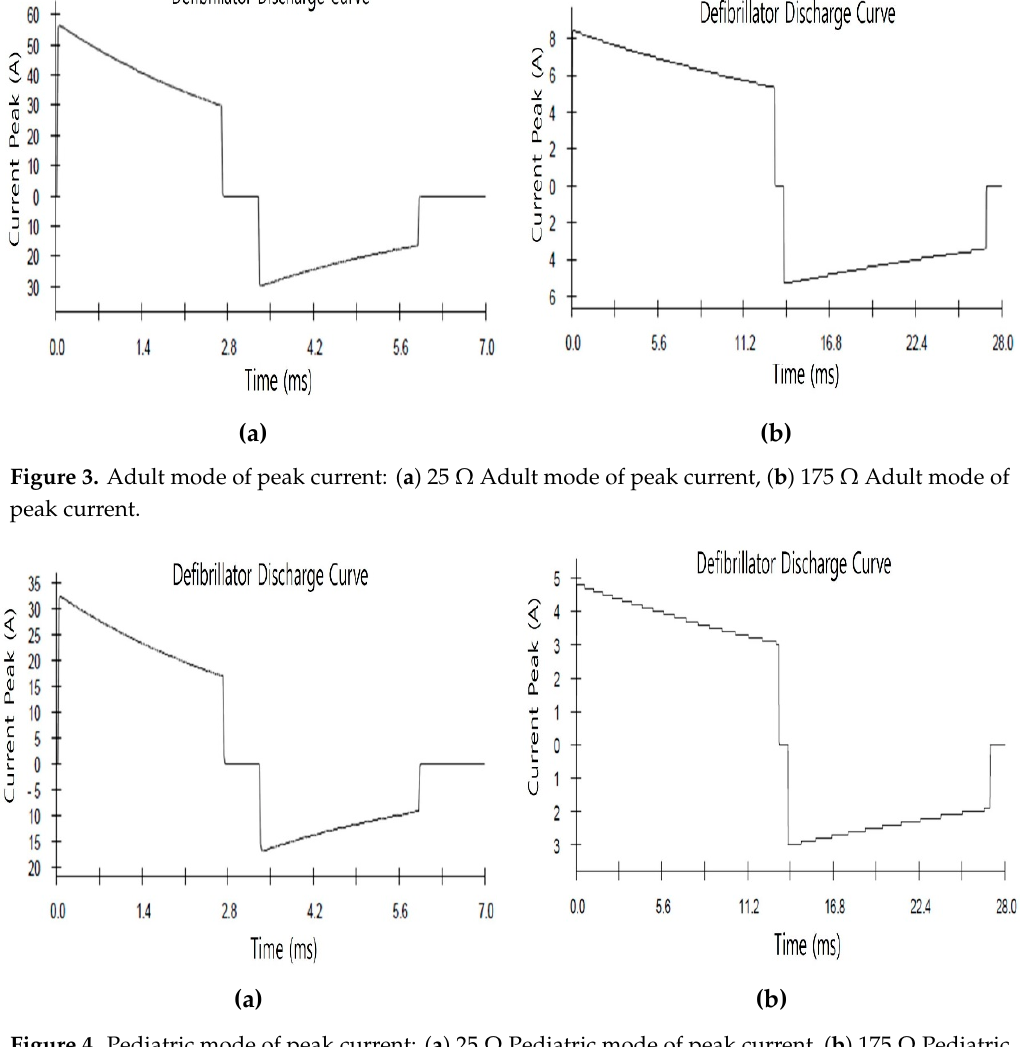
Figure 4. Pediatric mode of peak current: ( a ) 25 Ω Pediatric mode of peak current, ( b ) 175 Ω Pediatric mode of peak